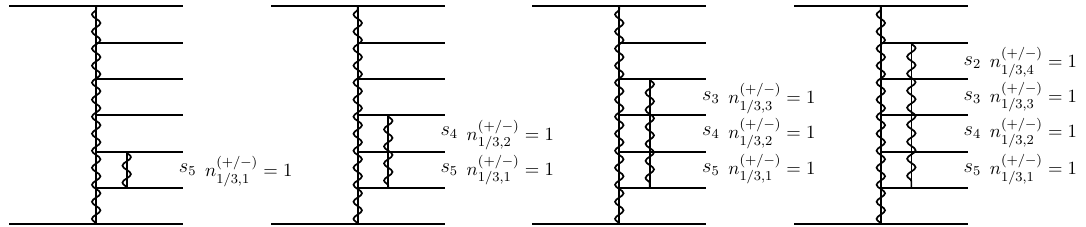
Figure 7 . Two-Reggeon bound states spanning different channels and their realization given in terms of the numbers n (+ / − ) of crossing singularities in the corresponding channels. 1 / 3 ,s scattering amplitude in the Euclidean region, which agrees with the field theory predictions (see [25]). Therefore, we proceed by looking at Mandelstam regions, in which the remainder function does not